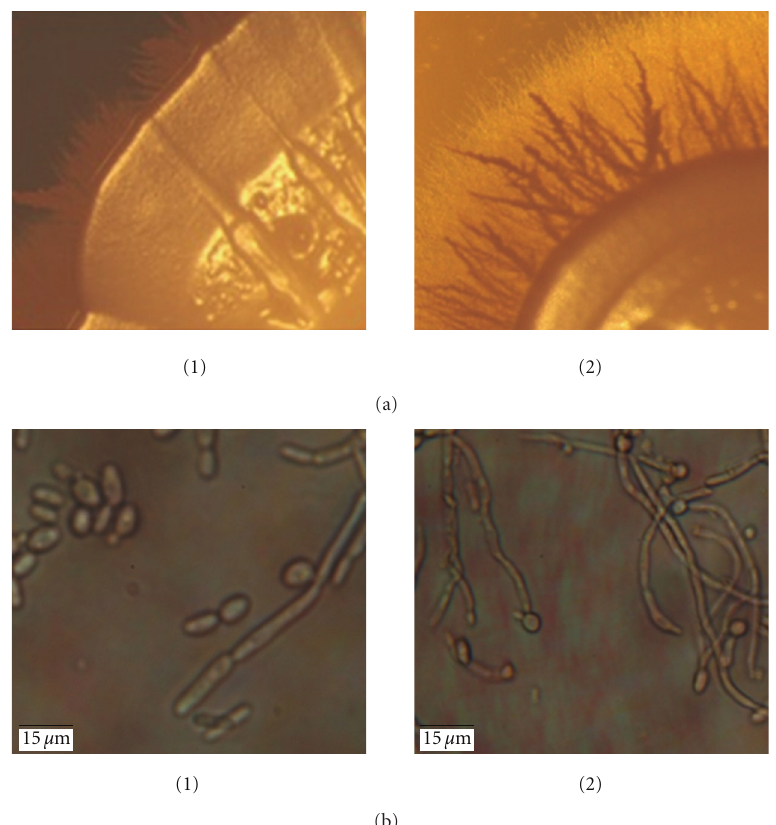
Figure 1: Colony morphology on solid and liquid media. (a) Colony morphology of both wild-type (1) and heterozygote mutant (2) strains grown on PDA at 30 ◦ C clearly indicates an increase in filamentation and invasivness of the mutant compared to the wild type. (30x magnification). (b) Cell morphology in PDB media after 24 h incubation at 37 ◦ C (1000x magnification).